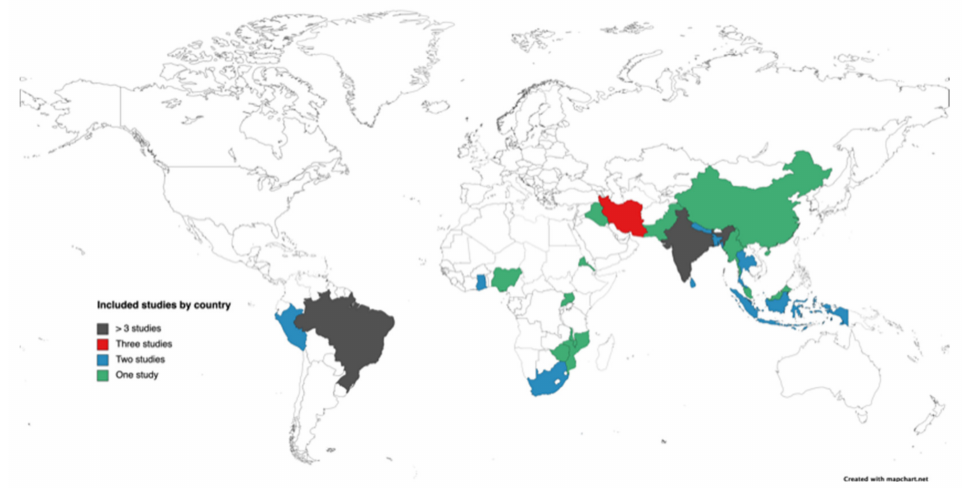
Figure 2. Overview of the included studies by geographical